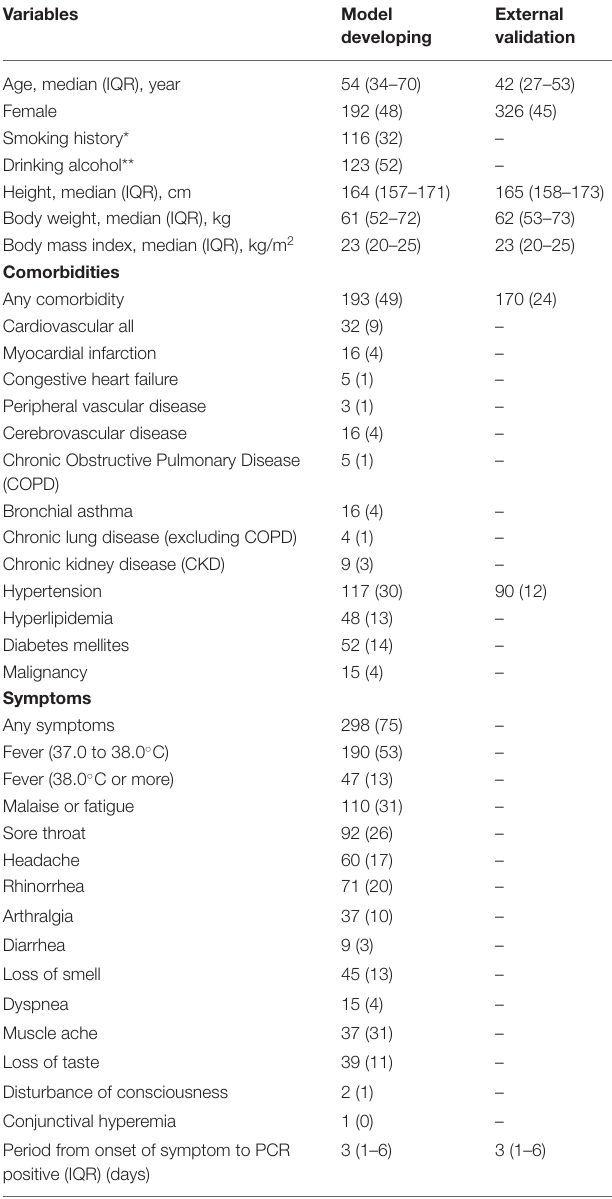
TABLE 1 | Characteristics of the patient on the admission of the patients with